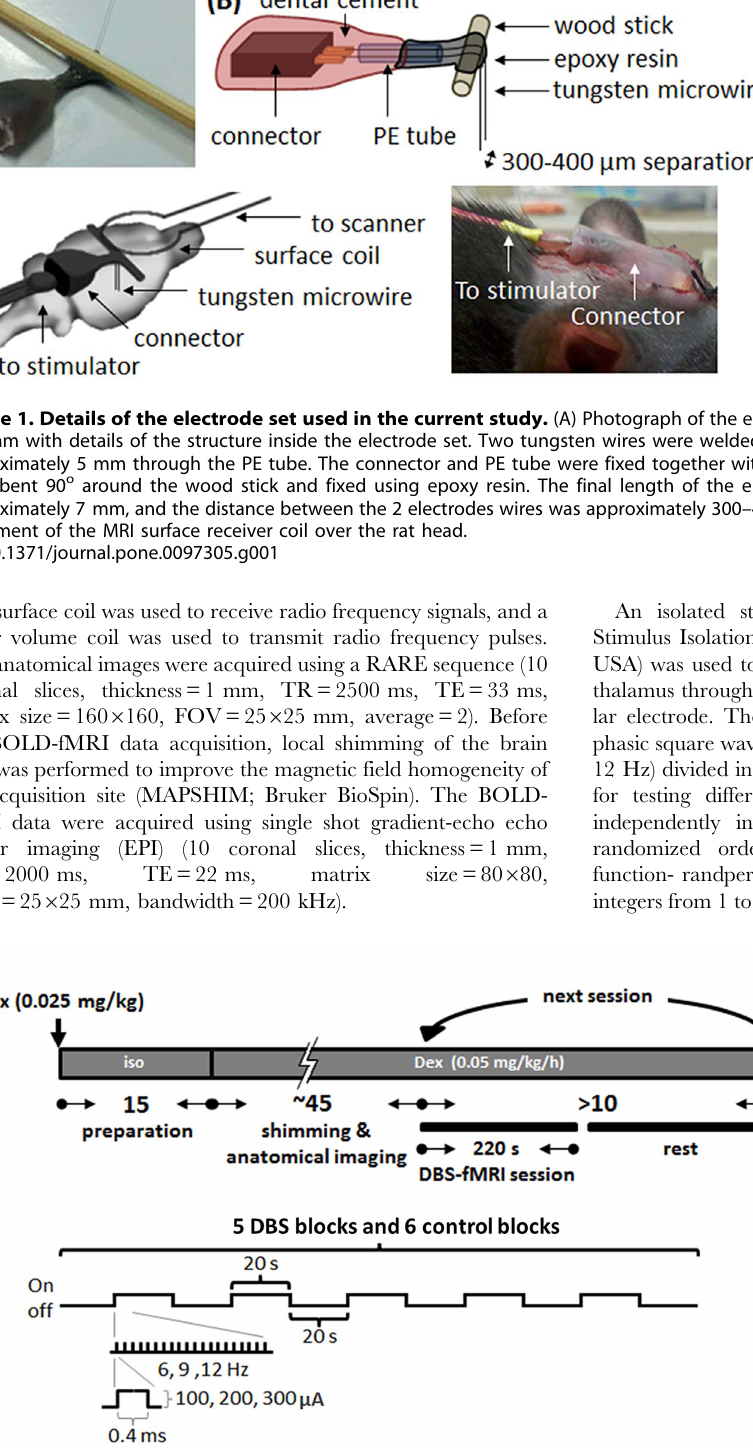
Figure 2. Experimental protocol. (A) Protocol for MRI scanning. For dexmedetomidine (Dex) based fMRI, the animal was first anesthetized using 5% isoflurane (Iso), then received a bolus of 0.025 mg/kg Dex subcutaneously. Iso was stopped 15 min later, and a continuous subcutaneous infusion of Dex (0.05 mg/kg/h) was initiated 15 min later for maintenance throughout the MRI experiment. The first session of the fMRI test was performed 60 min after the first bolus of Dex application. Each session of the fMRI test was separated by an inter-session interval of at least 5 min. (B) Stimulation protocol for DBS-fMRI session. Monophasic constant electrical current pulses with 0.4 ms duration, and the intensity and frequency adjusted in variable values, ranging from 100 to 300 m A and 6 to 12 Hz, were given by the block design, including 5 DBS blocks (stimuli on) and 6 control blocks (stimuli off), each block lasted 20 s.